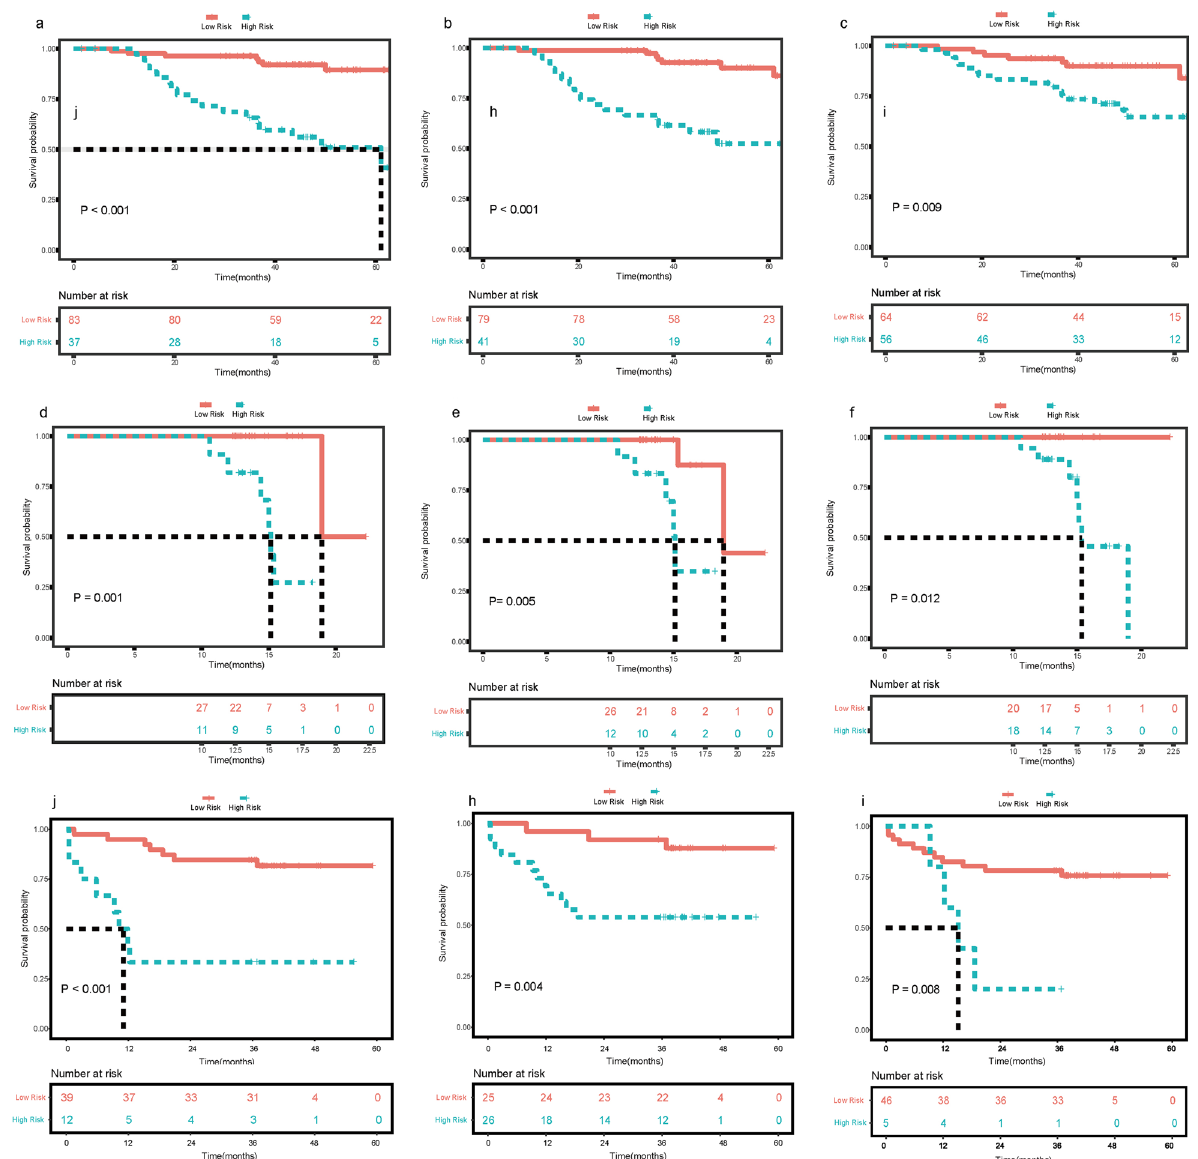
Fig. 5 Kaplan–Meier curves of patients’ overall survival in Early postoperative recurrence and Non- Early postoperative recurrence groups classified by models. a – c : Training Set; d – f : Internal validation Set; g – i : external validation set. ( a , c , g ) the Random Forest model with Boruta algorithm; ( b , e , h ) the Logistic regression model with stepwise selection method (Akaike information criterion); ( c , f , i ) the BCLC